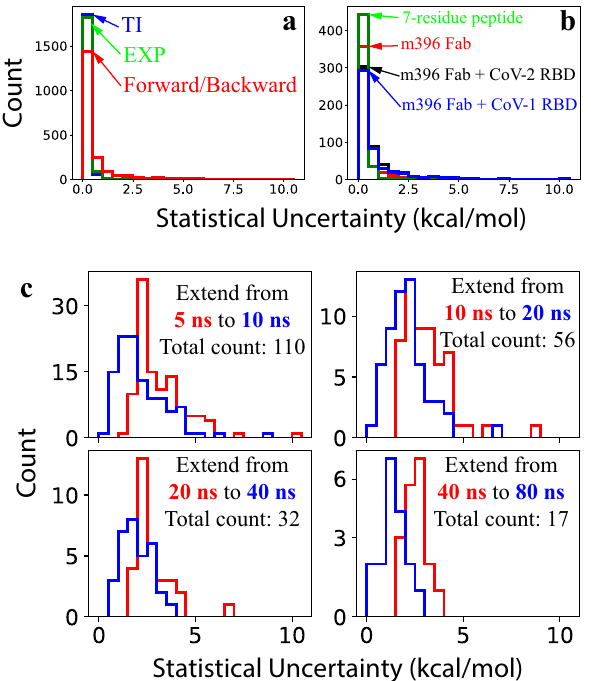
Figure 4. Distributions of the statistical uncertainties in the (cid:31) G calculations. ( a ) Histograms for the statistical errors estimated by three different methods, i.e., EXP, TI, and difference between the forward and backward simulation results, as described in “Analysis and error estimation”. ( b ) Histograms of the statistical errors in the original calculations, with 5 ns per window, for the four systems. ( c ) Comparisons of the uncertainty histograms after extending some of the sampling simulations from 5 to 10 ns, from 10 to 20 ns, from 20 to 40 ns, and from 40 to 80